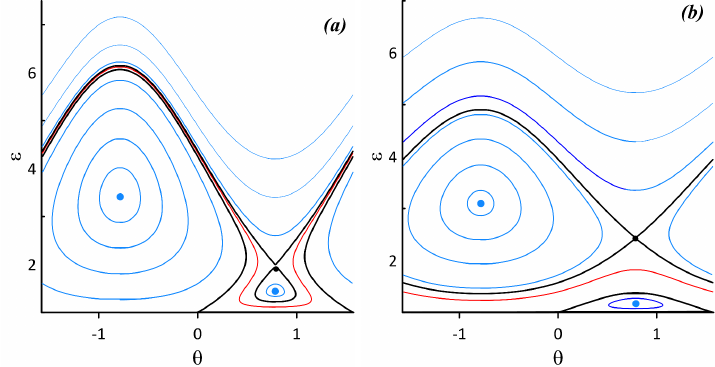
Figure 13. Phase portraits of the ellipsoid vortex motion corresponding to Regimes: ( a ) 4 ( e = 0.02 and γ = − 0.2); and ( b ) 6 ( e = 0.01 and γ = −